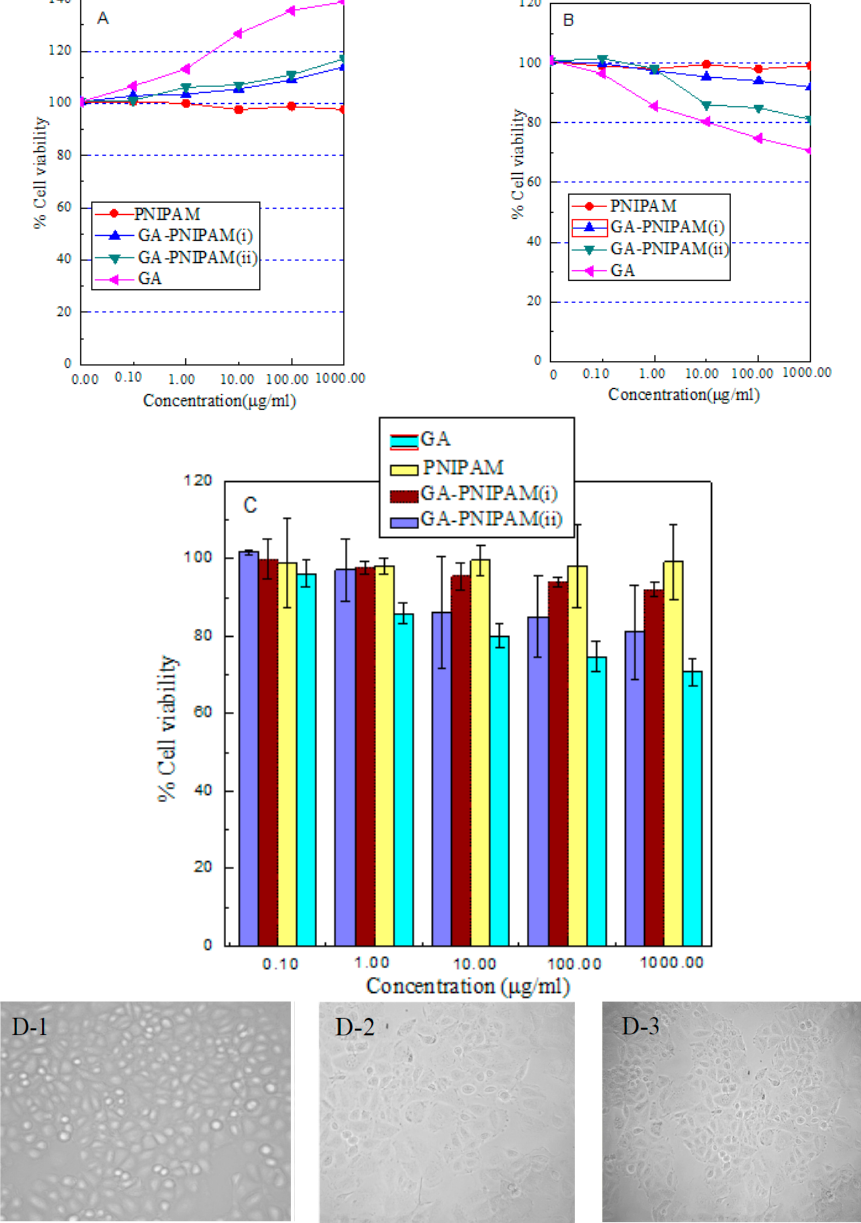
Figure 6. Cell viability of the ( A ) L-929 cells and ( B ) HepG2 cells incubated with the samples (PNIPAM homopolymer, GA-PNIPAM (i) and (ii); a range of sample concentrations from 0.1 to 1000 μ g/mL) by MTT assay for 48 h; and the ( C ) HepG2 cells exposed to increasing concentrations of samples for different times; ( D ) Images of HepG2 cells with reference group (D-1), GA group (D-2) and GA-PNIPAM group (ii) (D-3) under microscope.